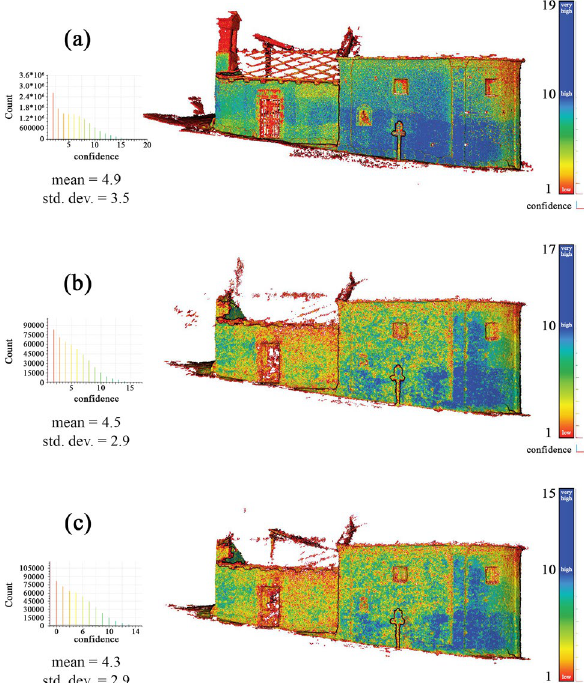
Figure 11 . Molini Allioni chapel, point clouds confidence: (a) dense point cloud derived from visible dataset; (b) dense point cloud derived from thermal dataset (Workflow 1); (c) dense point cloud derived from thermal dataset (Workflow 2).